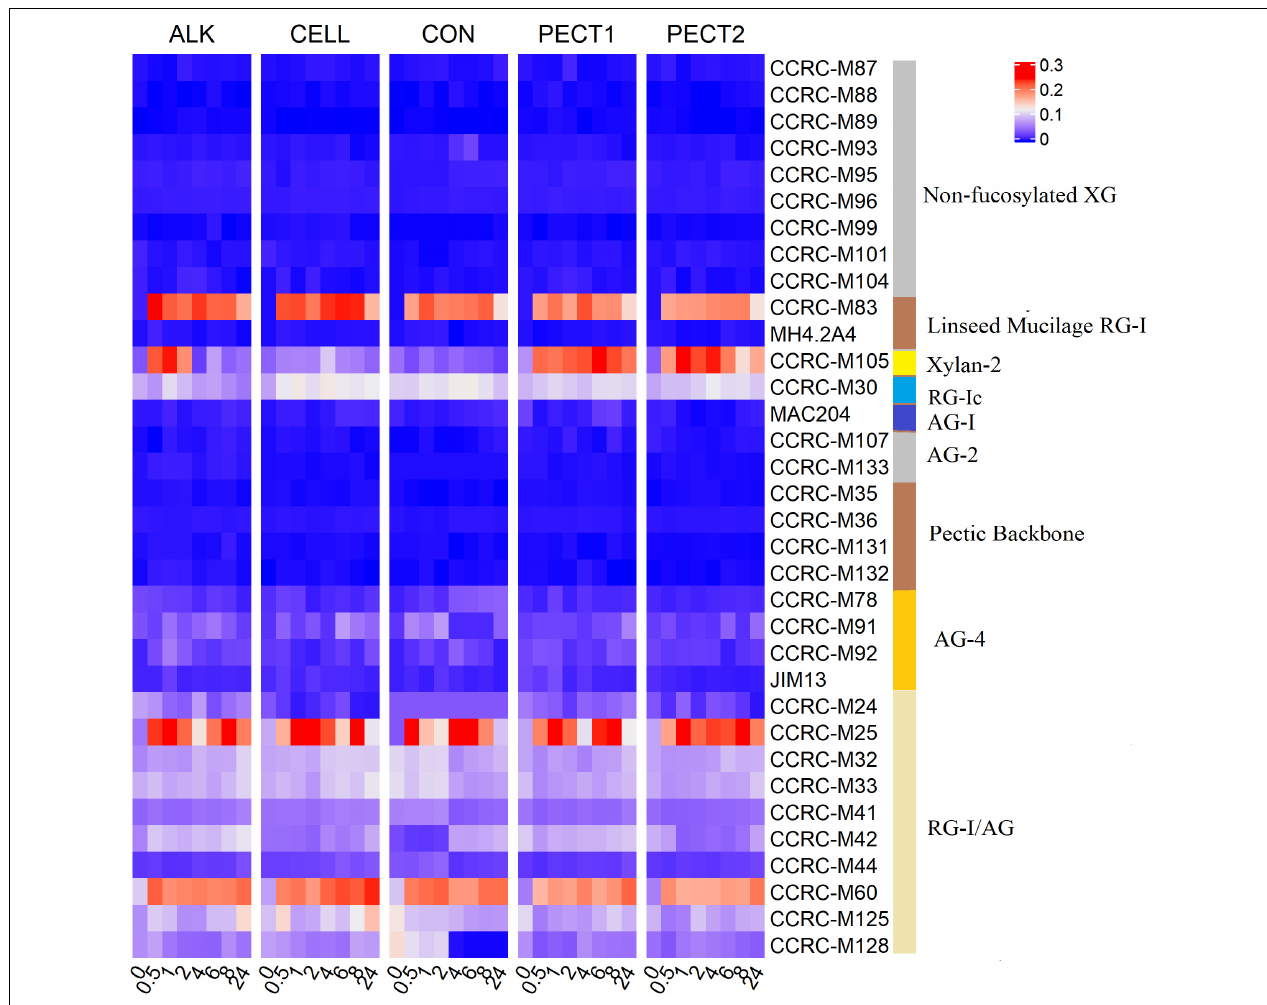
FIGURE 6 | Glycome profiling of lumen digests during in vitro fermentation of ALK, CELL, CON, PECT1, and PECT2 at time point 0, 0.5, 1, 2, 4, 6, 8, and 24 h. The binding response data are presented as heatmap using a blue-white-red scale indicating the strength of the ELISA signal (blue, white, and red colors depict no, medium, and strong binding, respectively). The mAbs are grouped based on the cell wall glycans they predominantly recognize as shown in the panel on the right-hand side of the figure. XG, xyloglucan; RG-I, rhamnogalacturonan I; AG, arabinogalactan; RG-I/AG, arabinogalactan side chains of